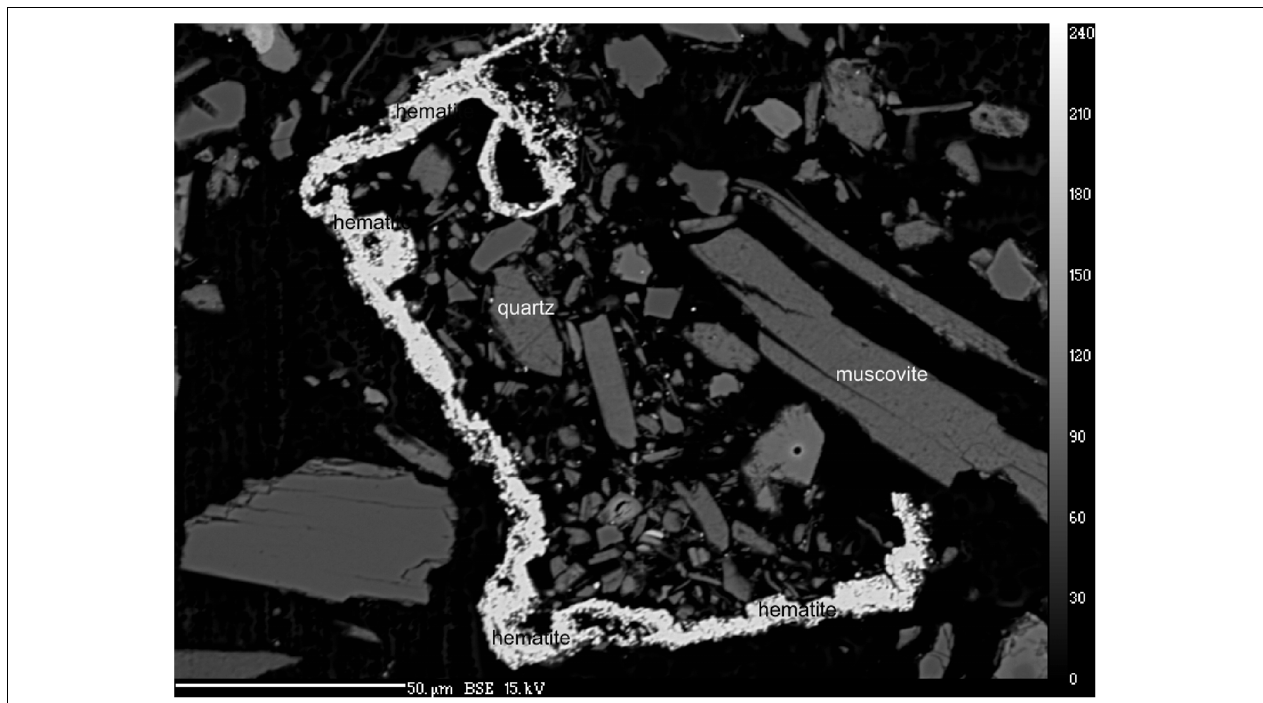
FIGURE 15 | Hematite determined by Electron Microprobe (EMP) in backscattered mode at Mindolo site, see explanation in